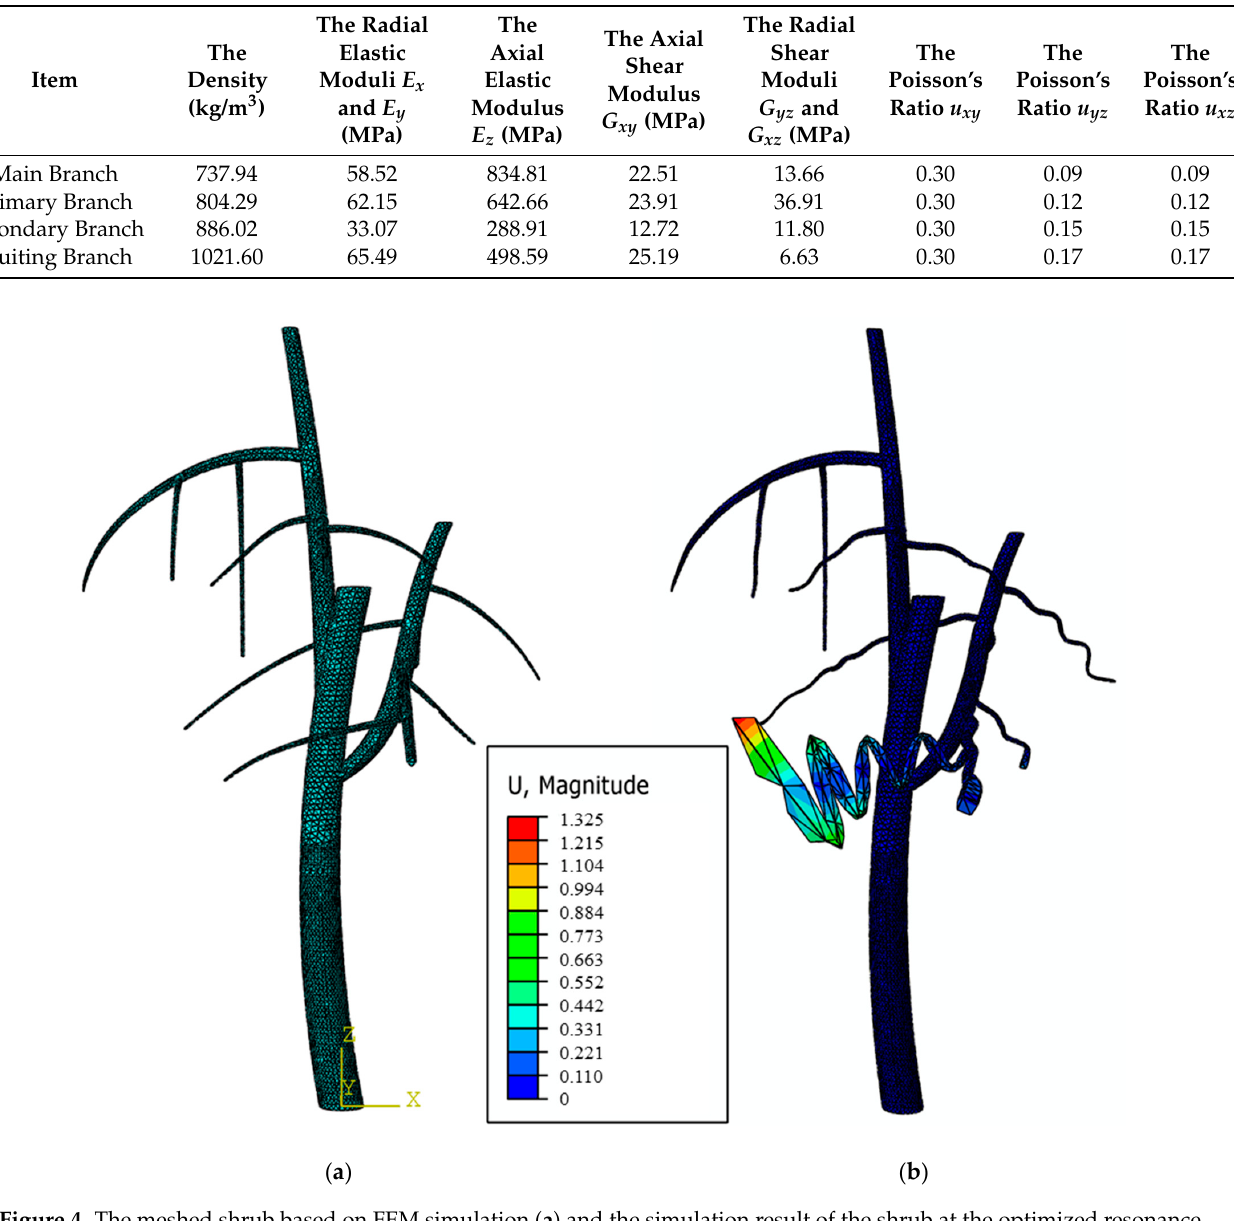
Table 2. The material mechanics parameters of the branches.